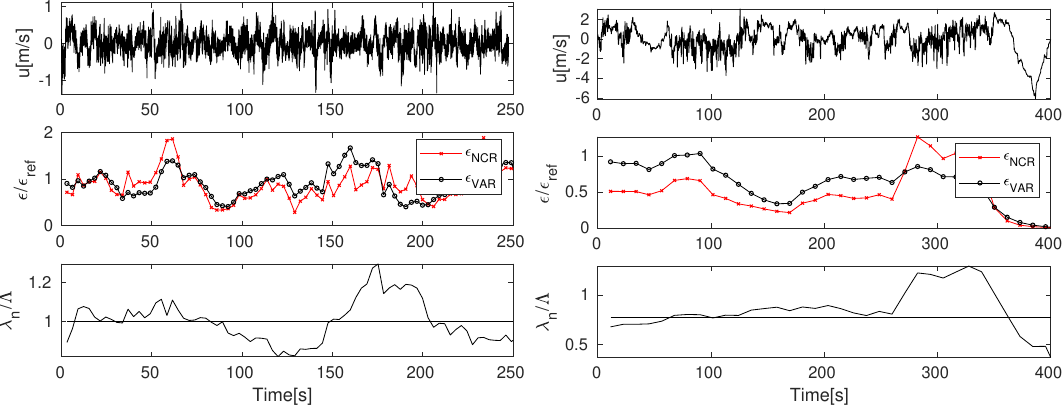
Figure 28. Top plots: Part of the POST signals, middle plots: (cid:101) estimates, bottom plots: Taylor-to Liepmann scale ratio. Left panel: horizontal segment of the flight 13, right panel: flight 3, signal recorded during vertical cloud